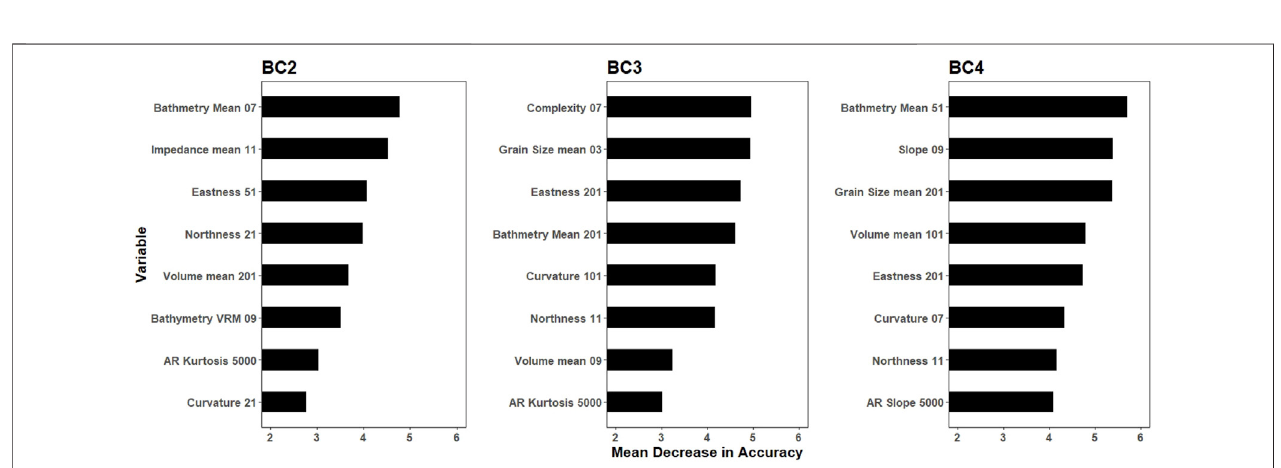
FIGURE 10 | Retained model variables for broad scale segmentation. The higher mean decrease accuracy the more important the variable is for the model.